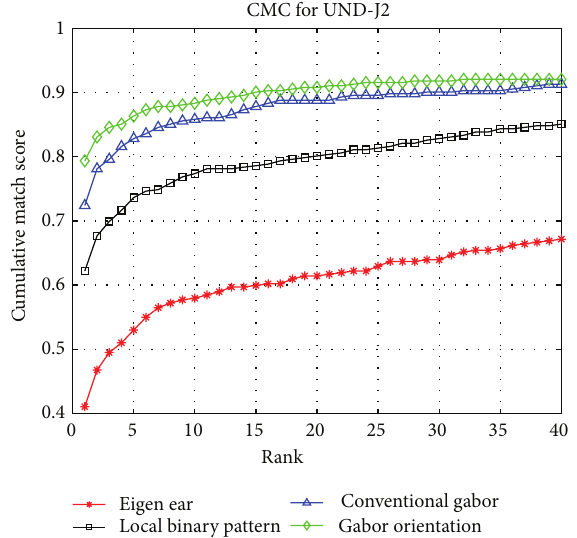
Figure 3: The CMC curves of rank 40 from the recognition experiments on UND ear database.